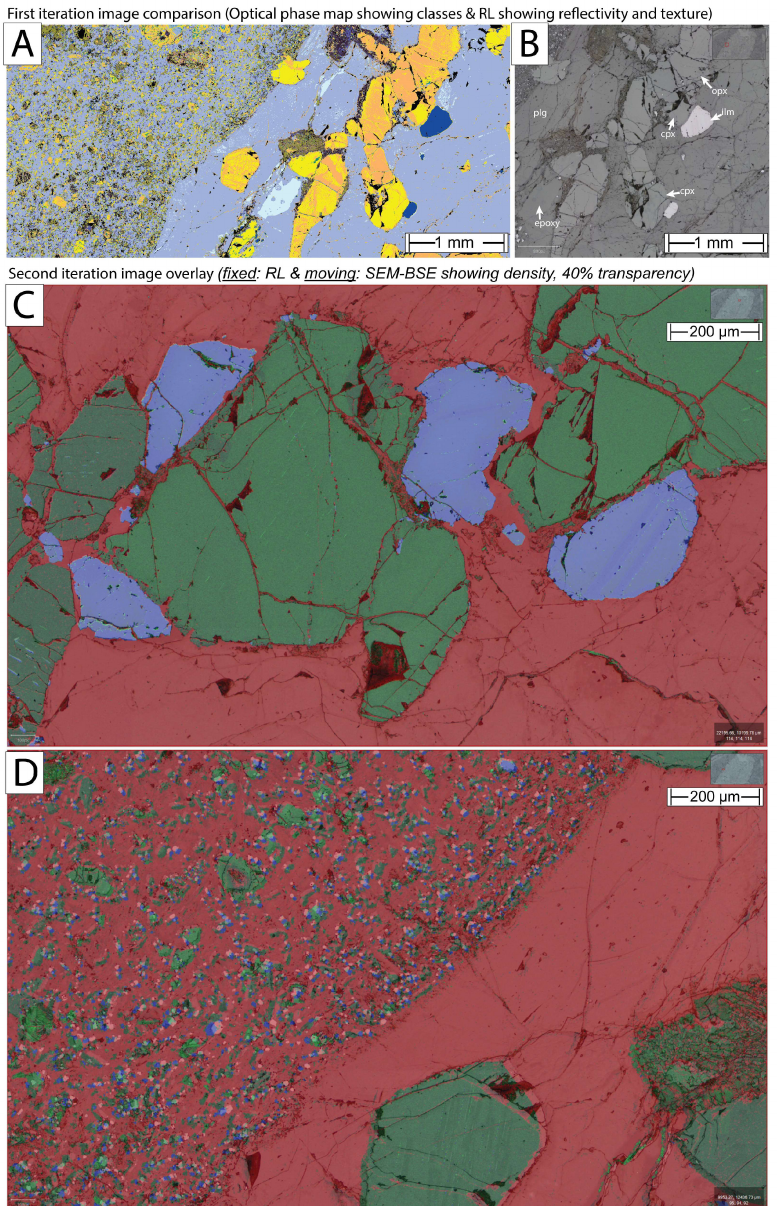
Figure 18. QuPath zoom-in to 10 × whole-slide image (WSI) of Figure 17. ( A ): iteration #1 phase map comparison alongside detailed RL image ( B ). This shows the imperfect distinction between the two pyroxenes. ( C ): Image overlay on medium-grained xenolith showing perfect image regis- tration between SEM-BSE (40% transparency) and RL, which contain complementary information. ( D ): Contact between xenolith and basalt matrix illustrating random pixel offsets (top-left and bottom- right) due to intrinsic deformation within montages. Top-right inlets show fields-of-view (FoV) locations. Sample ID: